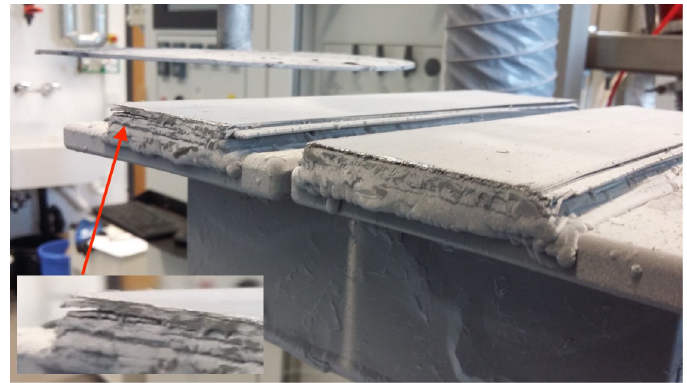
Figure 5. Side view of the samples produced after 20 layers.